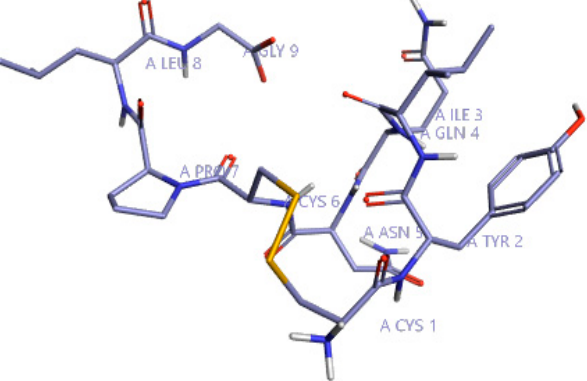
Figure 1. Three-dimensional structure of oxytocin visualized using Forge visualization Figure 1. Three ‐ dimensional structure of oxytocin visualized using Forge visualization software.